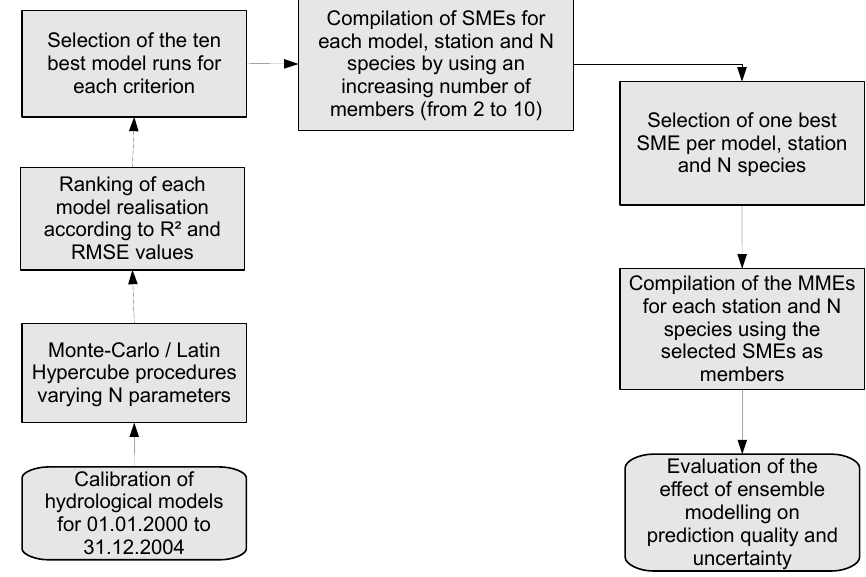
Fig. 3. Methodology used in this study to compile SMEs and